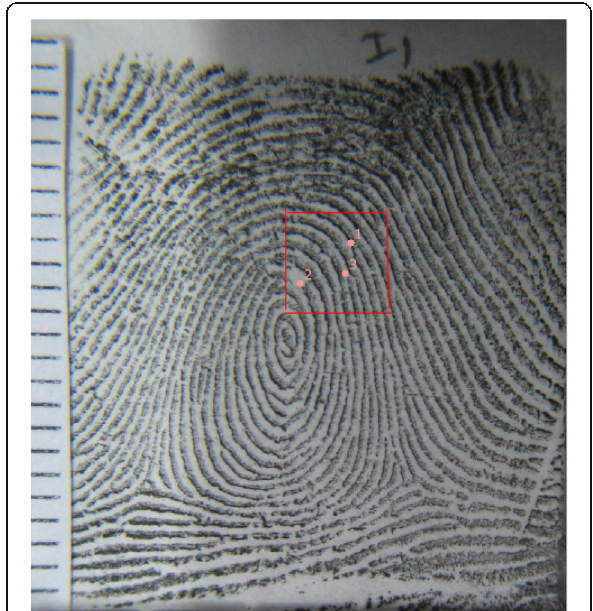
Fig. 3 Showing print of Index finger of female Subject and 3 bifurcation marked red colour with the help of count tool in Adobe Photoshop cs5